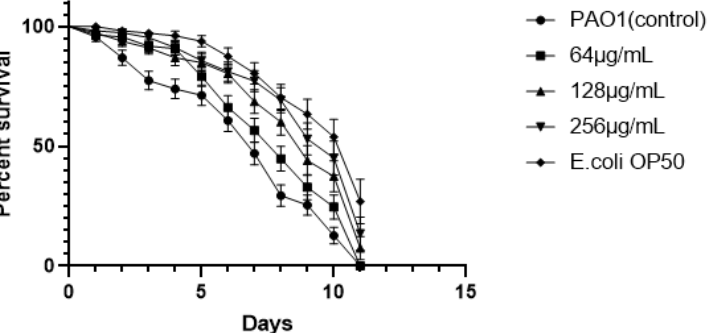
Figure 12. EGCG decreased the supernatant toxicity of P. aeruginosa. (All data are representative of three independent experiments performed in triplicate and expressed as the mean ± SD values in each bar.